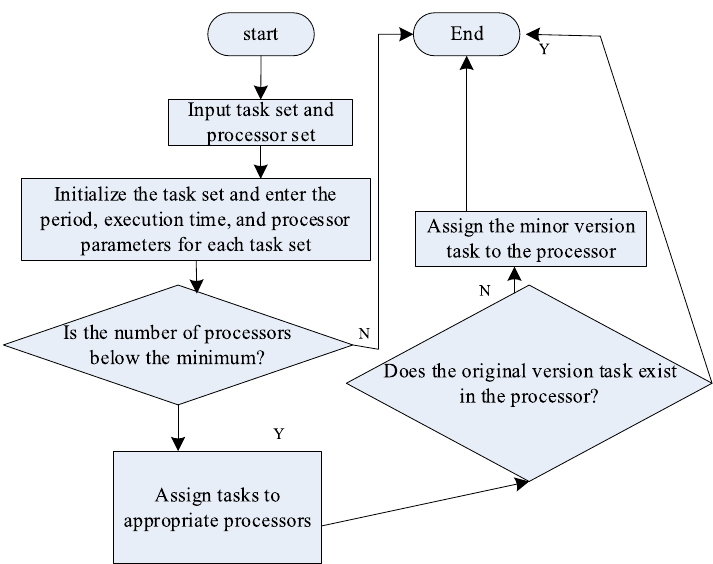
Fig. 2 Intermediate data fault tolerance model of the specific